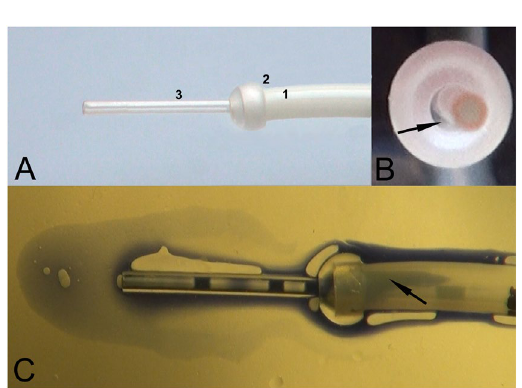
Figure 2. Sites of embryo retention and fluid propagation during embryo transfer. ( A ) Sites of embryo retention in descending order of occurrence: 1 - space between inner catheter and catheter sheath, 2 – surface of the catheter sheath, 3 – surface of the inner catheter; ( B ) Anterior view of the embryo transfer catheter. An arrow indicates the space between the inner catheter and catheter sheath; and ( C ) Propagation of the transferred load inside the uterine cavity model with pressure-gradient force directed toward the catheter. An arrow indicates the transferred liquid in the space between the inner catheter and catheter